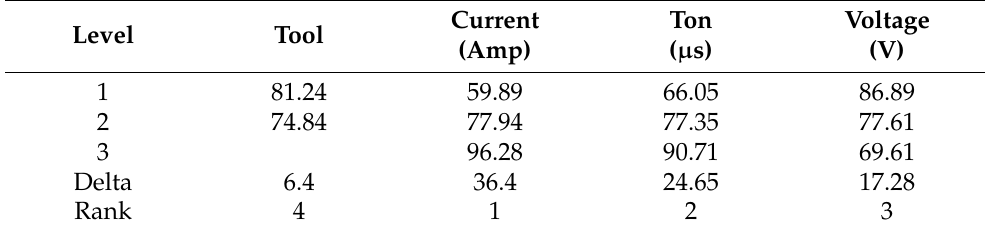
Table 6. Response table for MRR (mg/min).